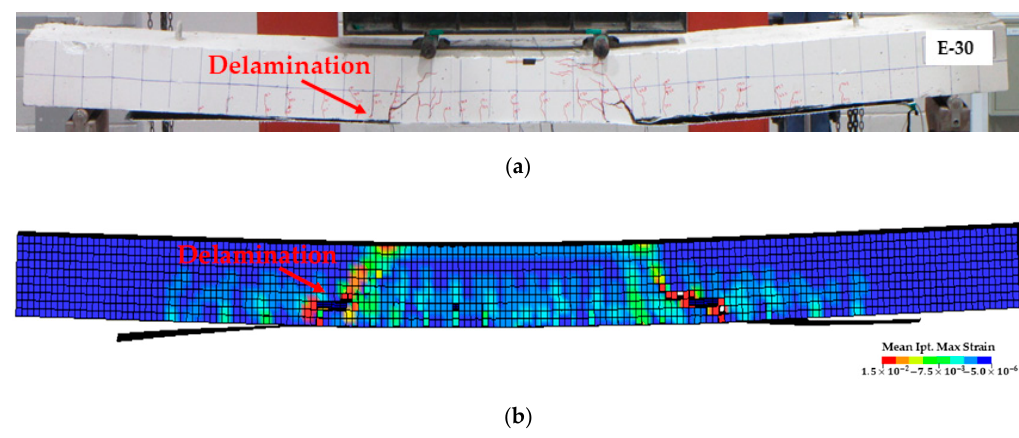
Figure 6. Delamination failure mode (E-30). ( a ) Experiment, ( b ) Analysis.